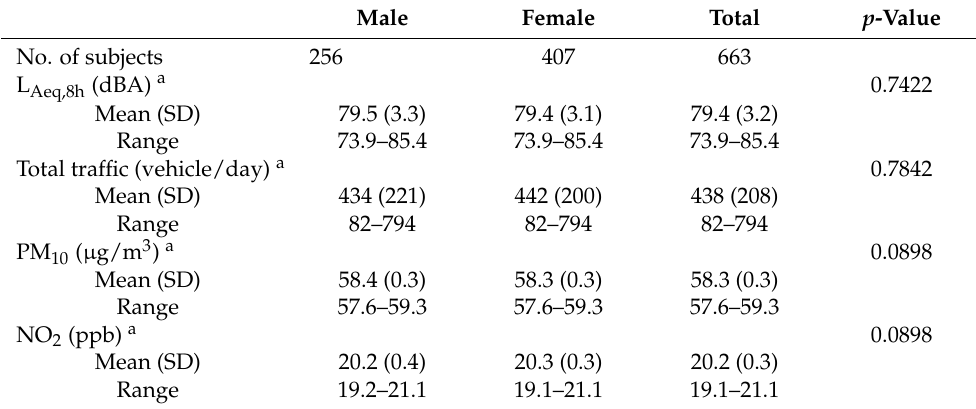
Table 2. Road traffic noise and air pollutants among study